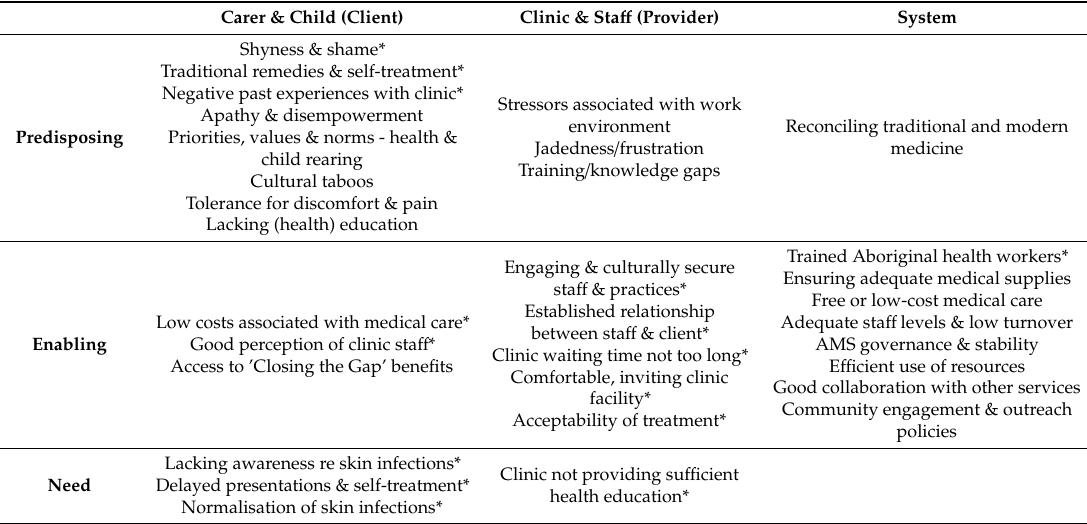
Table 4. Factors that a ff ect health service utilisation in remote Pilbara communities according to healthcare